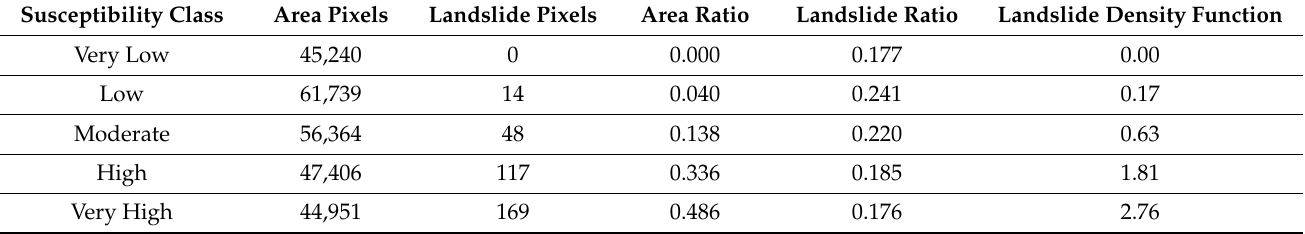
Table 5. Landslide Density Function for the Susceptibility Classes using Validation Landslide Dataset.